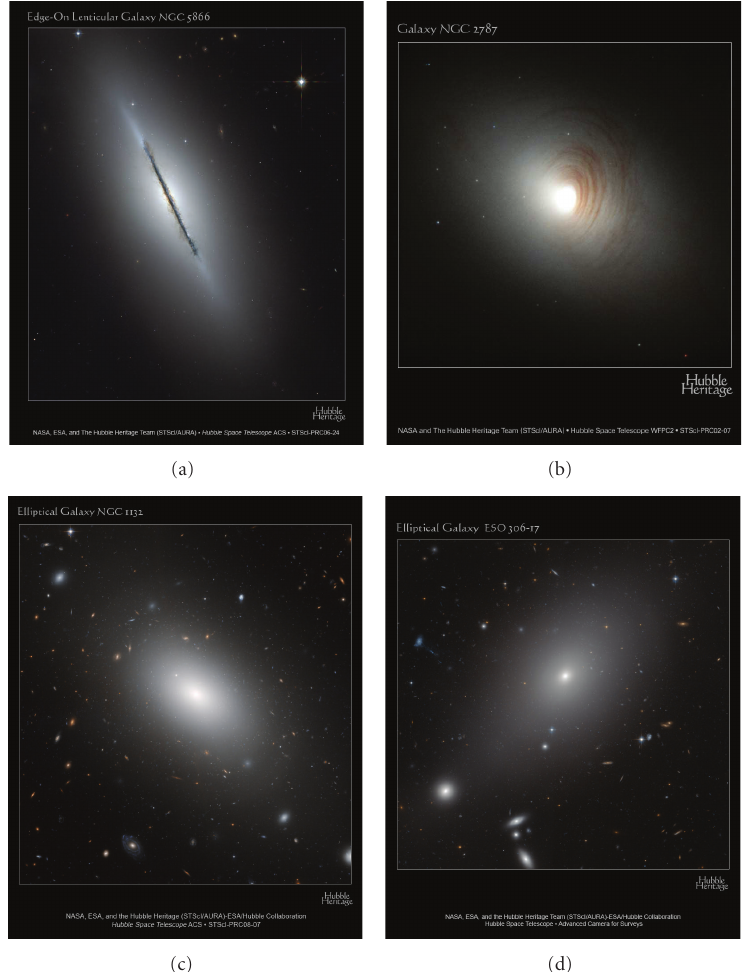
Figure 2: HST images of two S0 galaxies, NGC5866 (a) and NGC2787 (b), and two ellipticals, NGC1132 (c) and ESO306-17 (d). Credit: NASA, ESA, and The Hubble Heritage Team